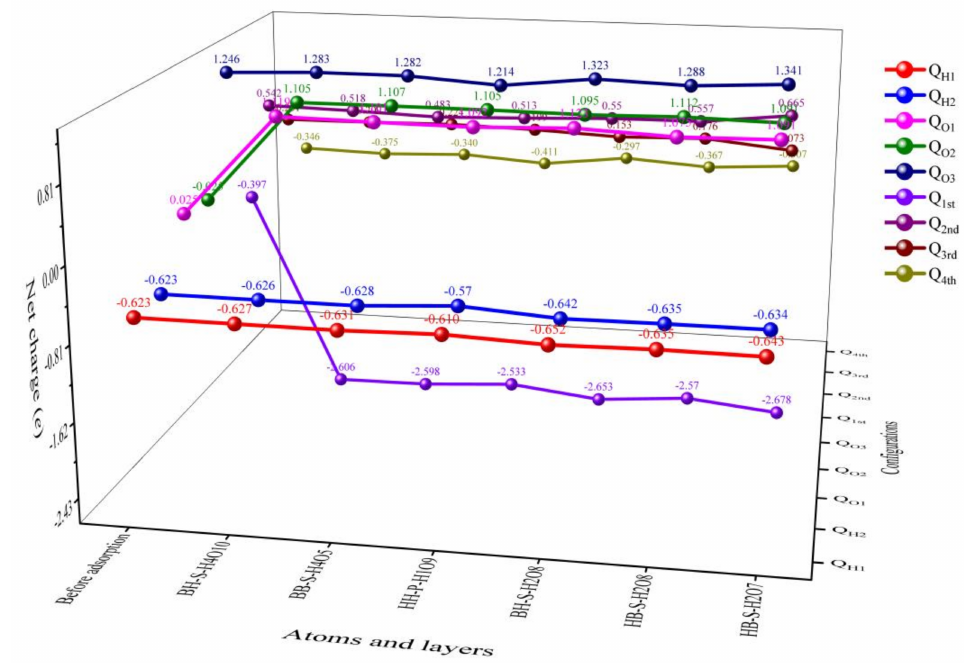
Figure 7. The trend figure of net charge distribution of co-adsorption stable configuration obtained when O 2 is preferentially adsorbed.